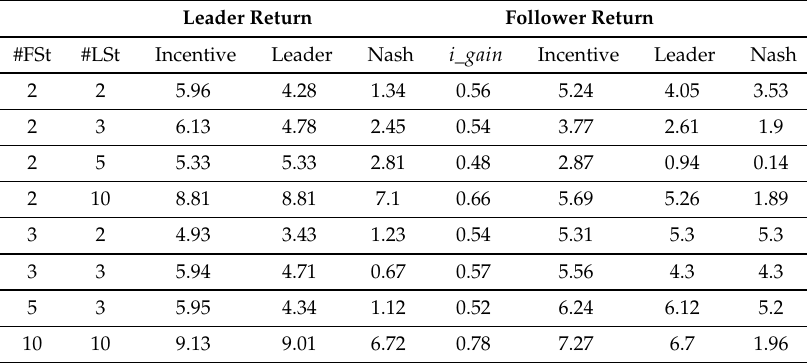
Table 14. Average leader return and follower return in different equilibria. Leader Return Follower